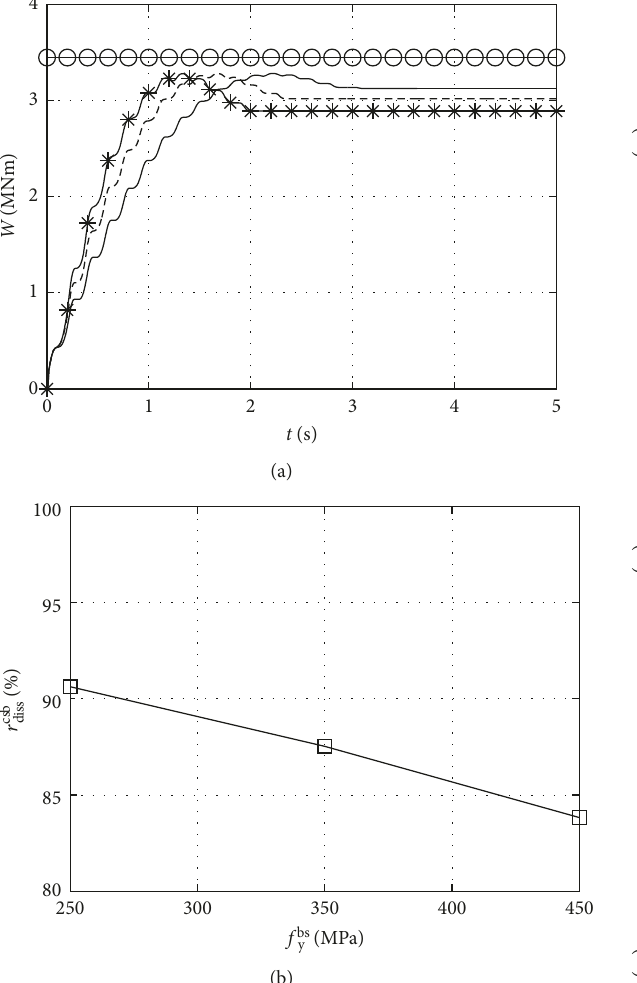
Figure 11: Time histories of energy absorbed by the device (a) corresponding to different yielding strengths of beam steel and the ratio of energy absorbed by the device after impact to the total impact energy, respectively, versus yielding strength of beam steel f bs (b). y